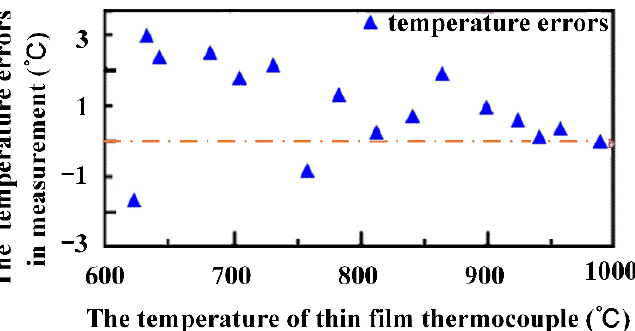
Figure 7. The temperature difference between the pyrometer and the thin-film thermocouple at 600 – 1000 °C.